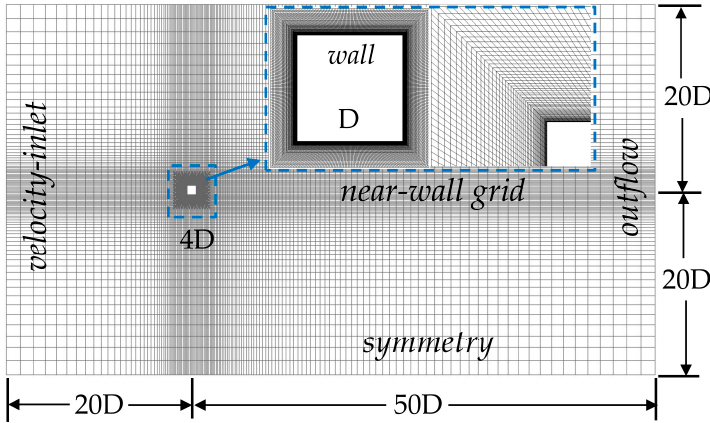
Figure 3. Dimensions and mesh partition of the computational domain.